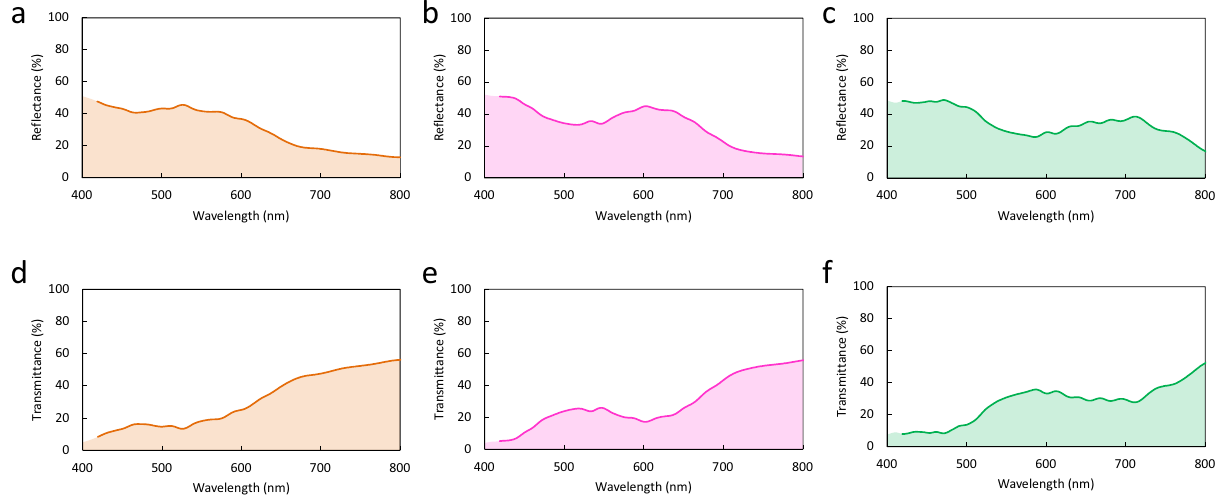
Figure 4. Calculated reflection and transmission spectra of three pearls. ( a – c ) Calculated reflection spectra of orange, pink-green, and green pearls, respectively. The incident angle is 0°. ( d – f ) Calculated transmission spectra of three pearls for normal